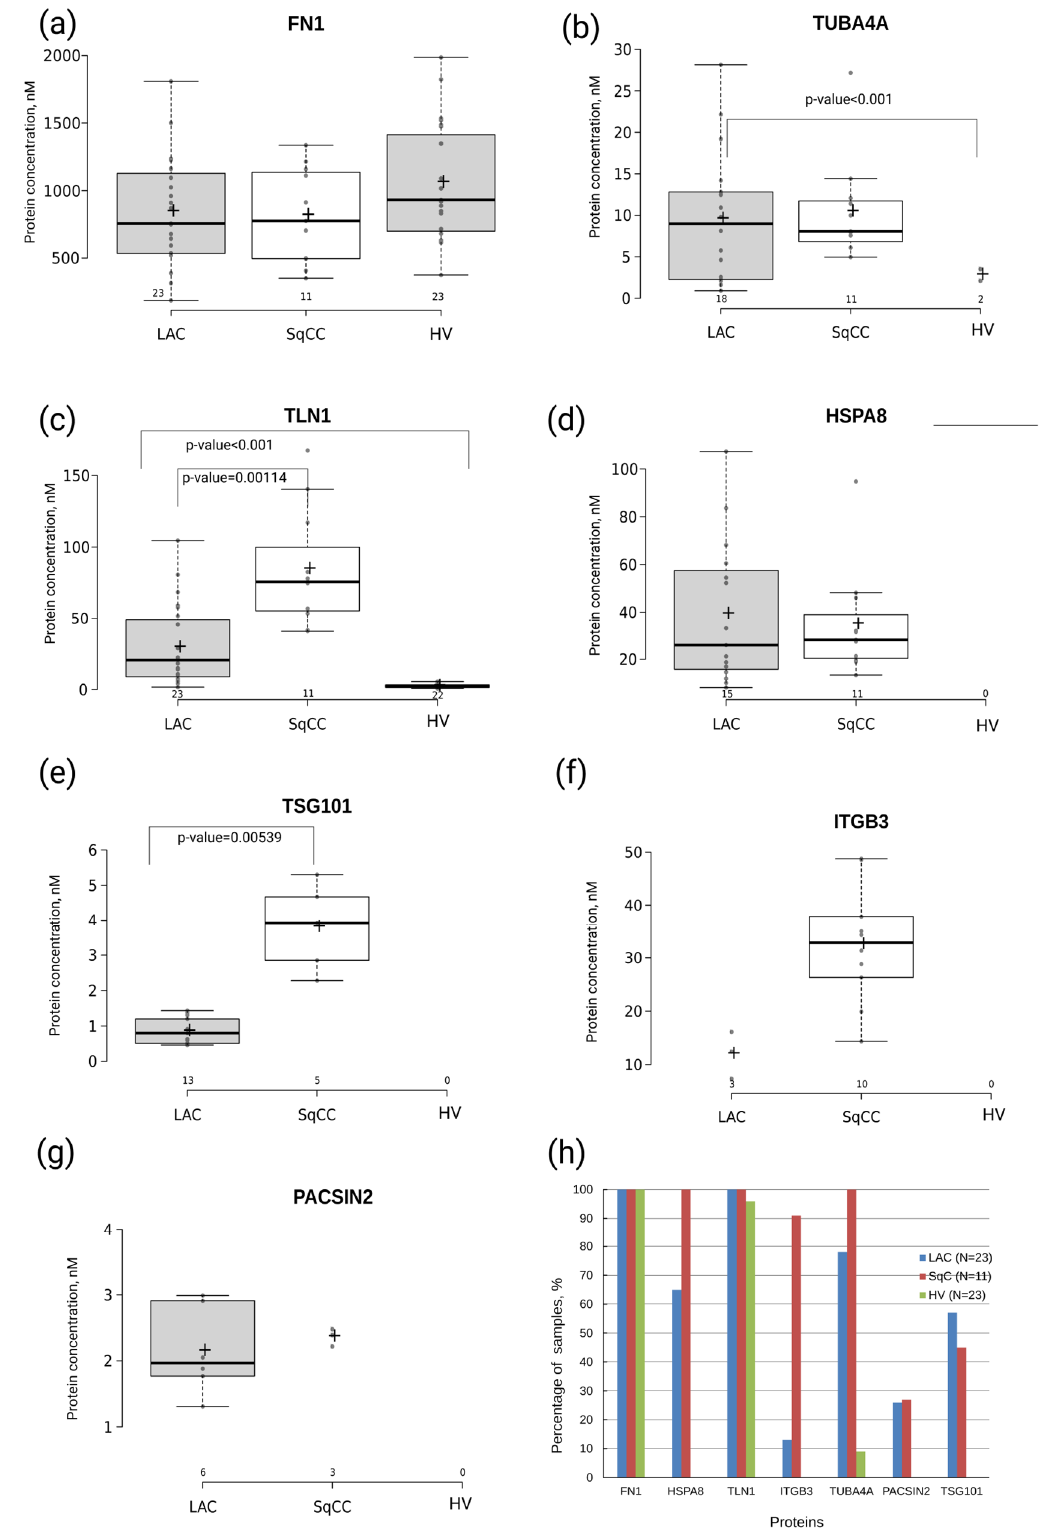
Figure 3. Results of the SRM/SIS measurements of the EV proteomic signature: ( a ) FN1; ( b ) TUBA4A; ( c ) TLN1; ( d ) HSPA8; ( e ) TSG101; ( f ) ITGB3; and ( g ) PACSIN2 in undepleted blood plasma derived from patients with lung adenocarcinoma (LAC, N = 23), lung squamous cell carcinoma (SqC, N = 11), and healthy volunteers (HV, N = 23). The distribution of protein content is shown as a boxplot chart if protein was measured in at least 5 samples per group. Protein concentration is shown in nM. The cross indicates the mean concentration of the detected proteins. ( h ) Percentage of sample in which EV-associated proteins were detected.